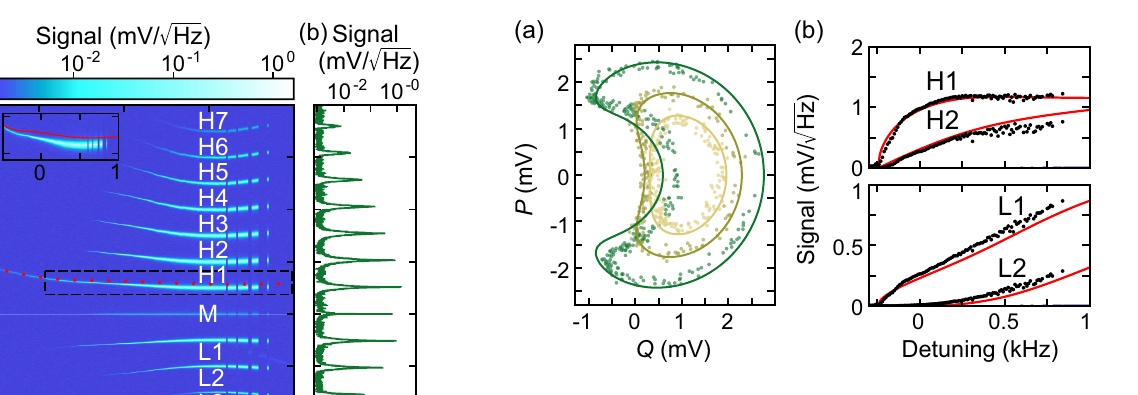
FIG. 5. Nonsinusoidal trajectories for detuned drive. (a) Trajec- tories in the rotating frame for a detuning of 0 Hz (yellow), 250 Hz (olive), and 850 Hz (dark green) at a drive power of 0 dBm. Data have been rescaled as described in Appendix B. (b) Amplitude of the satellites H 1 , H 2 (top) as well as L 1 , L 2 (bottom) as a function of detuning from Fig. 4(a) (black dots), compared to the Fourier components obtained from the theory (red lines). FIG. 4. Frequency comb for detuned drive. (a) Power spectra − f measured for increasing detuning f 0 at a fixed drive power d of 0 dBm. The dotted line represents the theoretical model for H 1 . The inset magnifies the region indicated by the dashed box. Arrows indicate drive power of the trajectories depicted in Fig. 5(a). (b) Frequency comb in line cut of diagram (a) taken at a detuning of 840 Hz (dark green arrow). (c) Amplitude of forced vibrations at f as a function of detuning extracted from d diagram (a). Black data points refer to the large-amplitude solution, whereas light purple indicates the small-amplitude solution for which there is no instability. The dashed line represents the prediction based on the theory that disregards driving-induced friction, whereas the solid line includes it; see Eqs. (4) and